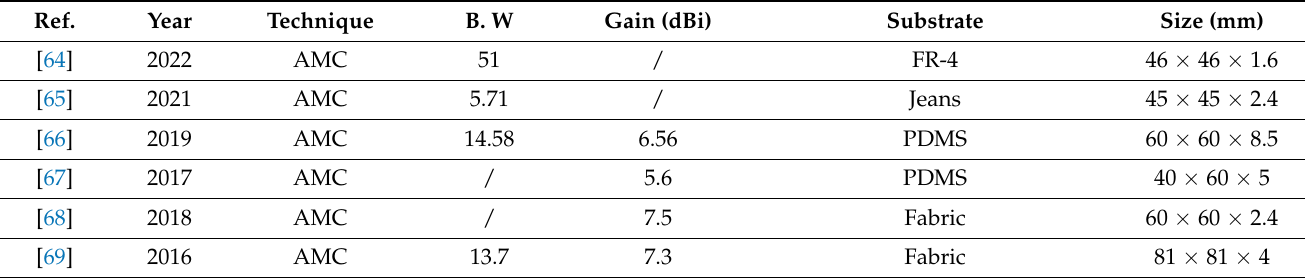
Table 6. Recent studies (AMC, PBG,